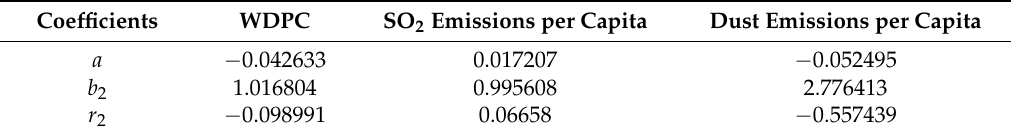
( 1 ) ( 1 ) = 1, and the equations of the corresponding time response are 1